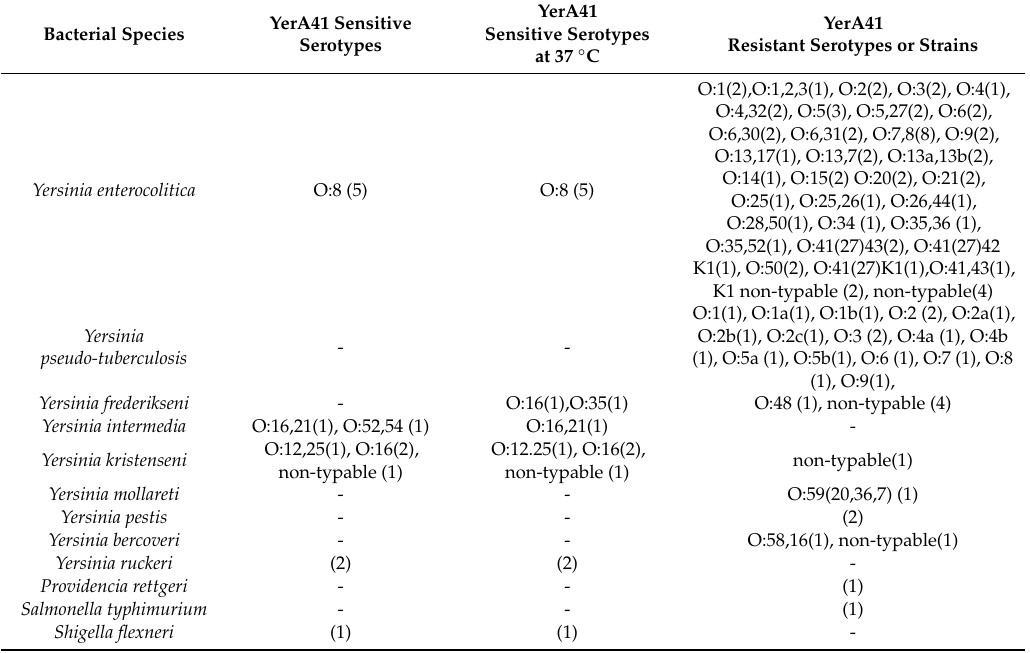
Table 1. Host range of bacteriophage YerA41 (numbers of studied strains for each species and serotype are given in parenthesis). The sensitivity was tested both at RT and at 37 ◦ C. YerA41 YerA41 Sensitive YerA41 Bacterial Species Sensitive Serotypes Resistant Serotypes or Serotypes at 37 ◦ C